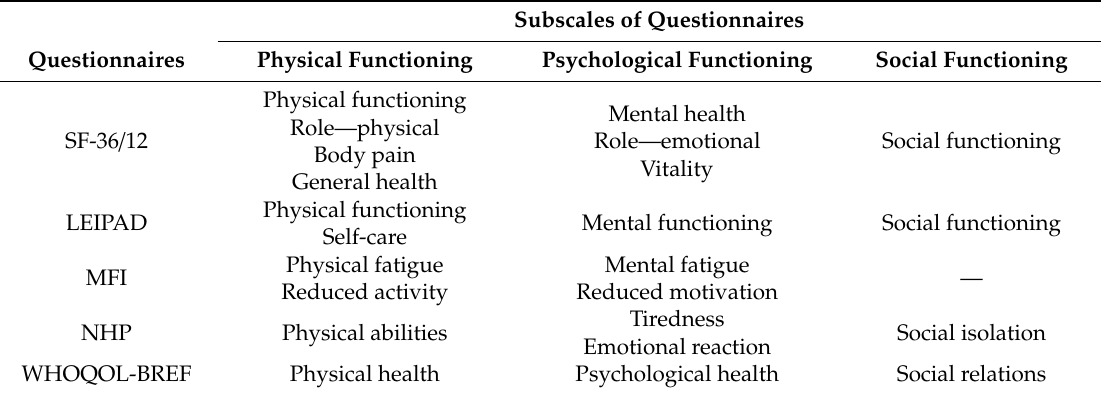
Table 2. Classification of subscales of the SF-36 / 12, LEIPAD, MFI, NHP, WHOQOL-BREF. Subscales of